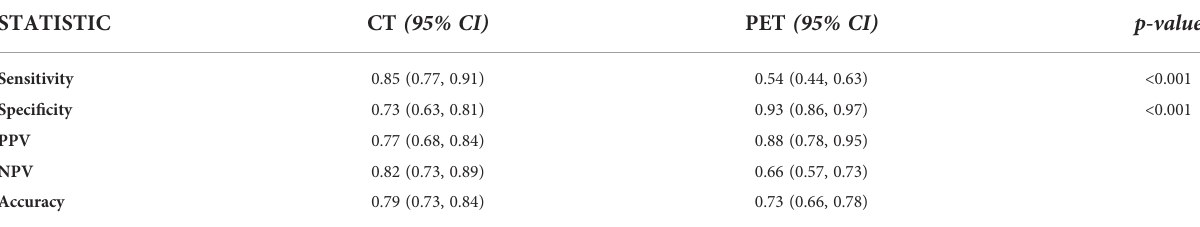
TABLE 3 Performance measures of CT, and PET with surgery and surgical histopathology as the reference standard for all evaluated stations (n=220).